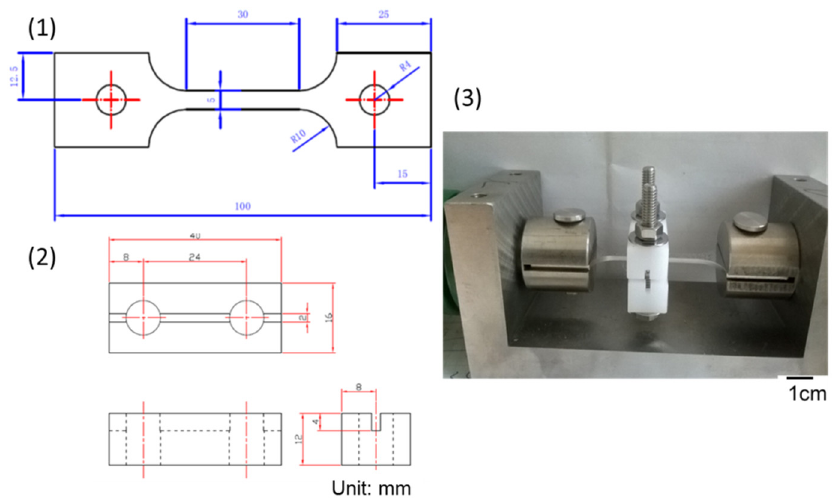
Figure 2. The dimensions of the SS 304L tensile test specimen and crevice former under tensile stress: (1) SS 304L specimen, (2) crevice former device, and (3) photo of the specimen set ‐ up.